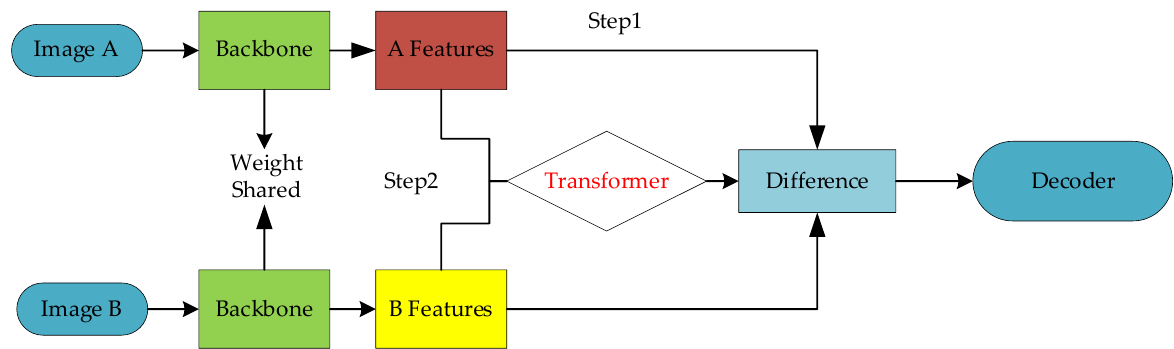
Figure 1. Method flow for our change detection network